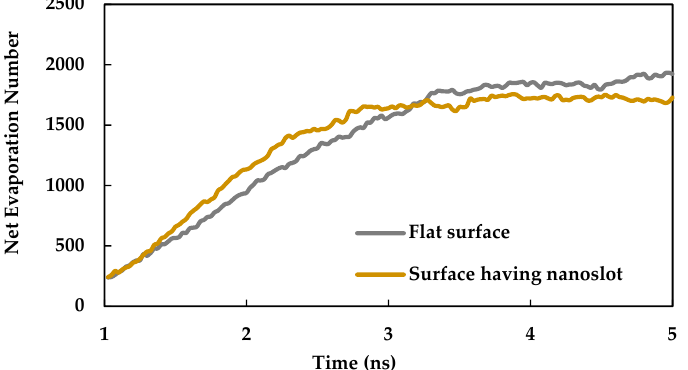
Figure 16. Comparison of density profile of argon at 4 ns for surface having nano slots with a smooth surface.